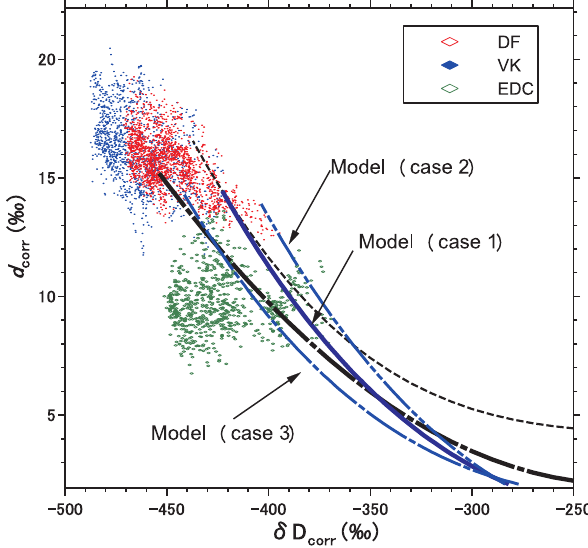
Fig. 4. Isotope ratios of Antarctic surface snow and ice cores. Re- gression curves of surface snow data from various parts of Antarc- tica (black dashed-dotted line) (Masson-Delmotte et al., 2008), and from Japanese–Swedish IPY 2007/2008 traverse covering Syowa- Dome F route (black dotted line) (Fukui et al., 2010). Simulated curves are shown as blue solid line (Case 1), bule double dotted line (Case 2) and blue dotted line (Case 3). Each case corresponds to different super saturation functions shown in Table 3. Dots repre- sent ice-core data of DF over the past 360kyr (red), Vostok over the past 250kyr (blue), and EDC over the past 140kyr (green). Here, δ D and d are corrected for δ 18 O sw , see text for